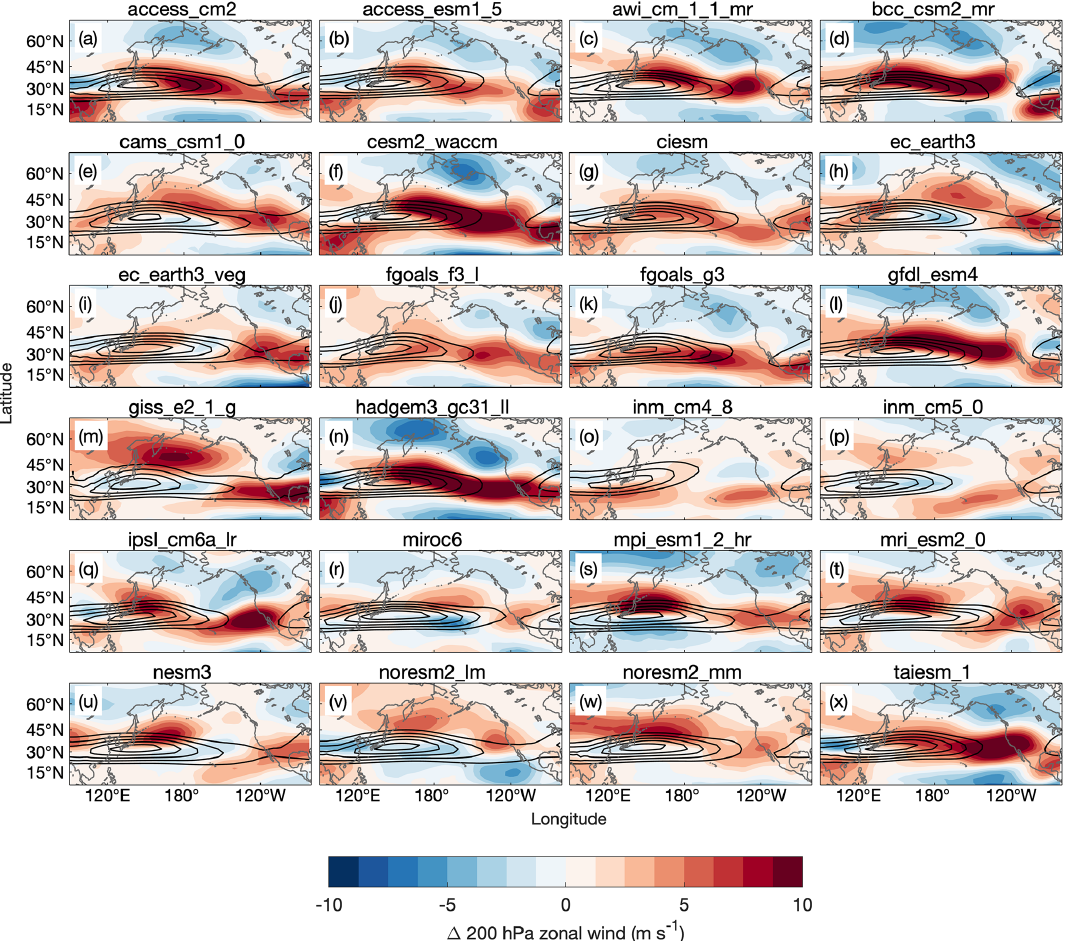
Figure A4. Shading is the difference in the January mean zonal wind at 200hPa between the historical (1985–2014) and future periods (2071–2100) for models included in the analysis. Solid black contours show the January mean zonal wind at 200hPa, starting at 35ms − 1 and increasing by 10ms − 1